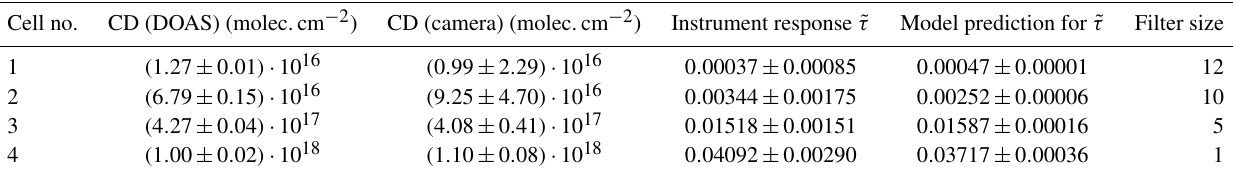
Table 1. Column densities and instrument signal ˜ τ of each reference cell measured with a DOAS instrument and the NO 2 camera. Cell no. CD (DOAS) (molec.cm − 2 ) CD (camera) (molec.cm − 2 )